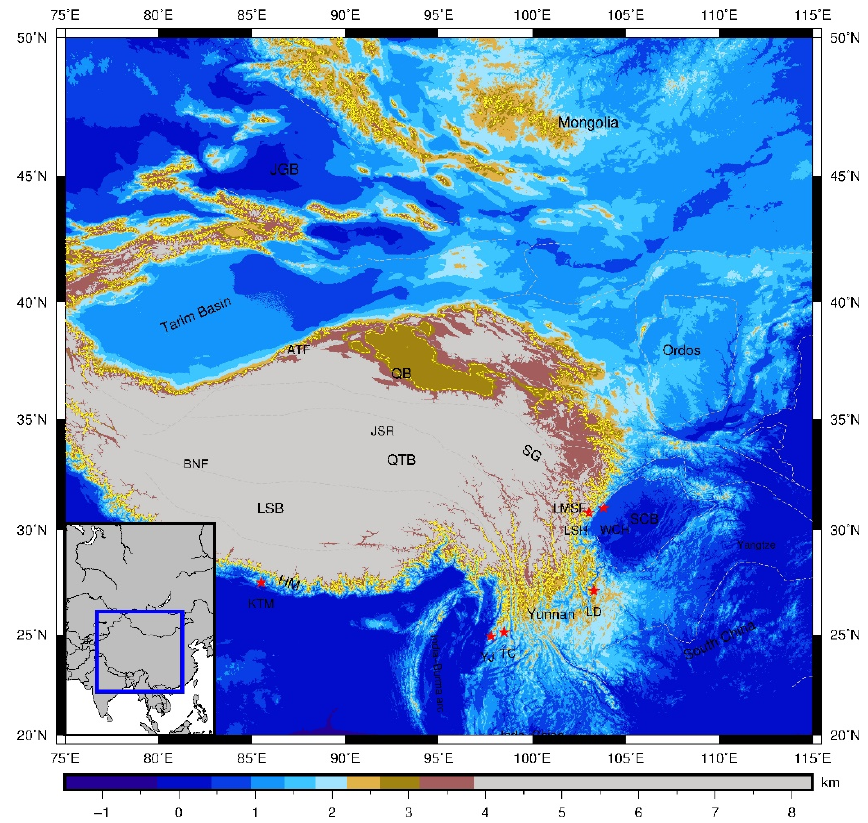
Figure 1. Topography and major tectonics of the density study area; in the figure: MBT—Main Boundary Thrust, MCT—Main Central Thrust, BNF—Bangong Nujiang Fault, JRS—Jinsha River Suture, ATF—Altun Tagh Fault, LMSF—Longmen Shan Fault, HM—Himalaya Block, LSB—Lhasa Block, QTB—Qiangtang Block, QB—Qaidam Block, SG—Songpan Ganzi Block, Tarim Basin—Tarim Basin, Ordos—Ordos Block, SCB—Sichuan Basin; Red stars mark the locations of earthquakes that have occurred in recent years and the volcano in the study area: WCH—epicenter of the 2008 8.0 M Wenchuan earthquake, LSH—epicenter of the 2013 7.0 M Lushan earthquake, LD—epicenter of the 2014 6.5 M Ludian earthquake, YJ—epicenter of the 2011 5.8 M Yingjiang earthquake; TC—Tengchong Volcano. (Note that, this is a new figure reusing only the fault data from [28].)